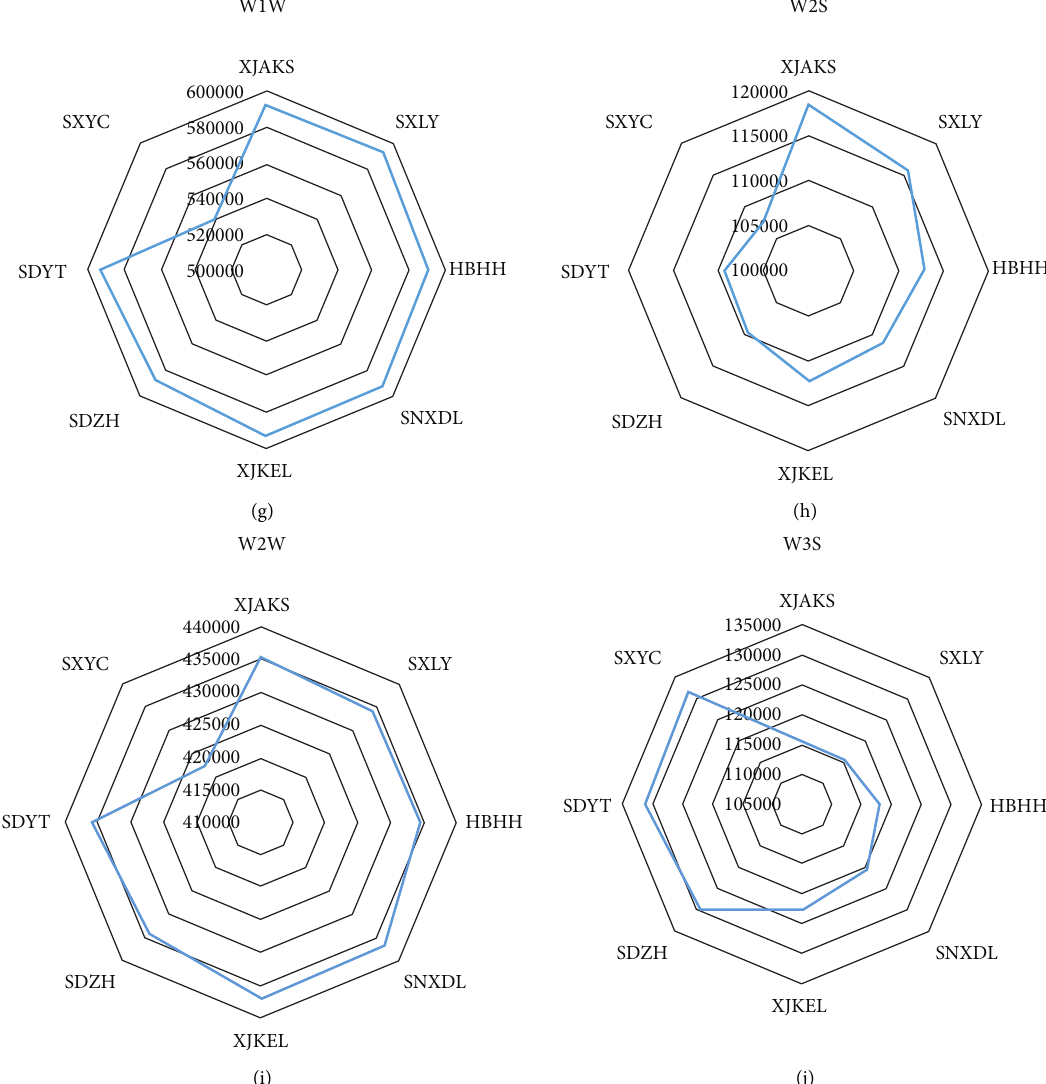
Figure 3: Response intensities of different sensors to aroma characteristics of different regions of winter jujube. (a–j) response on different